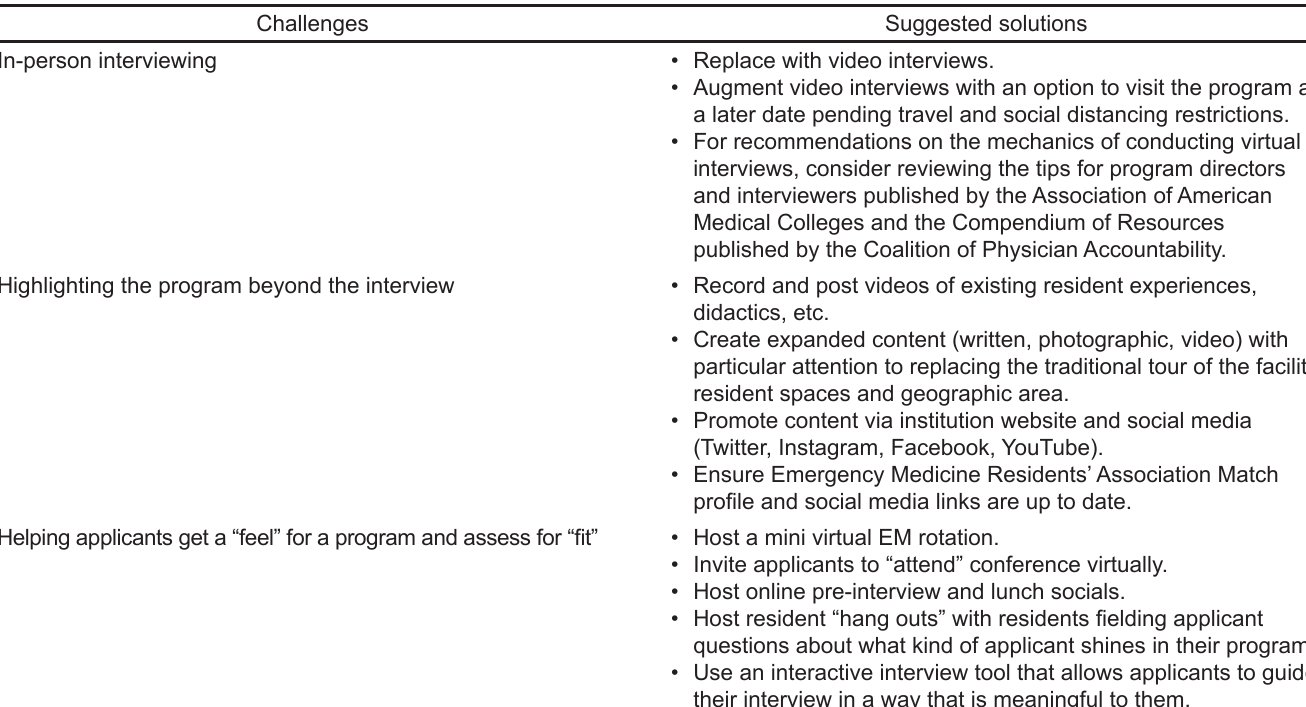
Table 2. Suggested solutions to address challenges in the emergency medicine residency interview process amidst